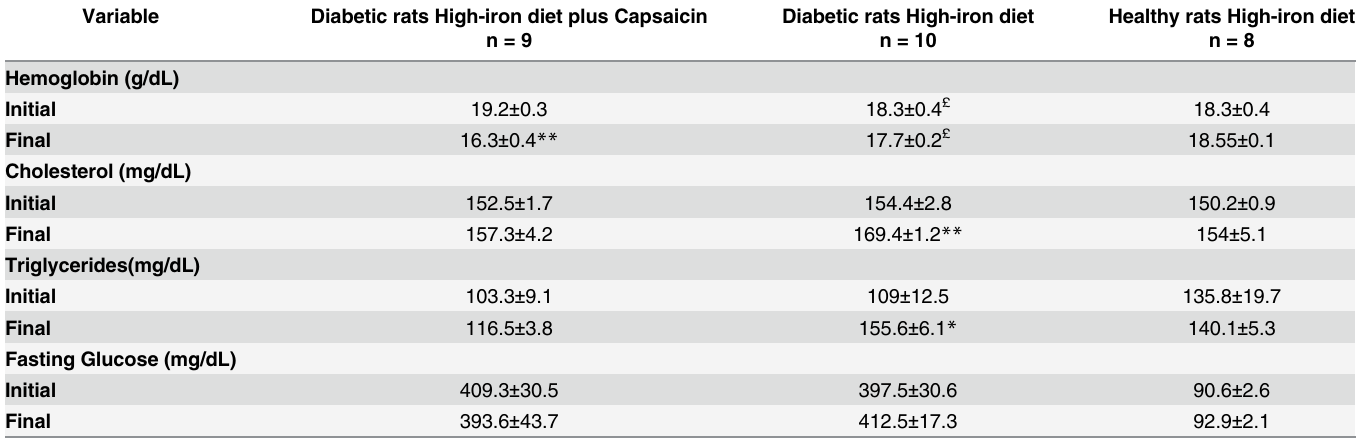
Table 4. Diabetic and healthy rats fed with high iron diet plus capsaicin. p value from paired Student t-test at the beginning and at the end of interven- tion. The dose of capsaicin used was 1 mg/kg body weight/day administered subcutaneously. Initial refers to values before intervention. Final refers to values after 4 weeks of intervention. To confirm the effects of diabetes on hemoglobin in the high-iron group, an additional group of seven rats were tested; those data have been added £ n = 17. The paired Student t-test was calculated with the lower n indicated at the top of the Table. In diabetic rats plus capsaicin the differences between initial and final values corresponds to death of one rat. In healthy rats with high iron the missing values at the beginning were due to tech- nical difficulties in the